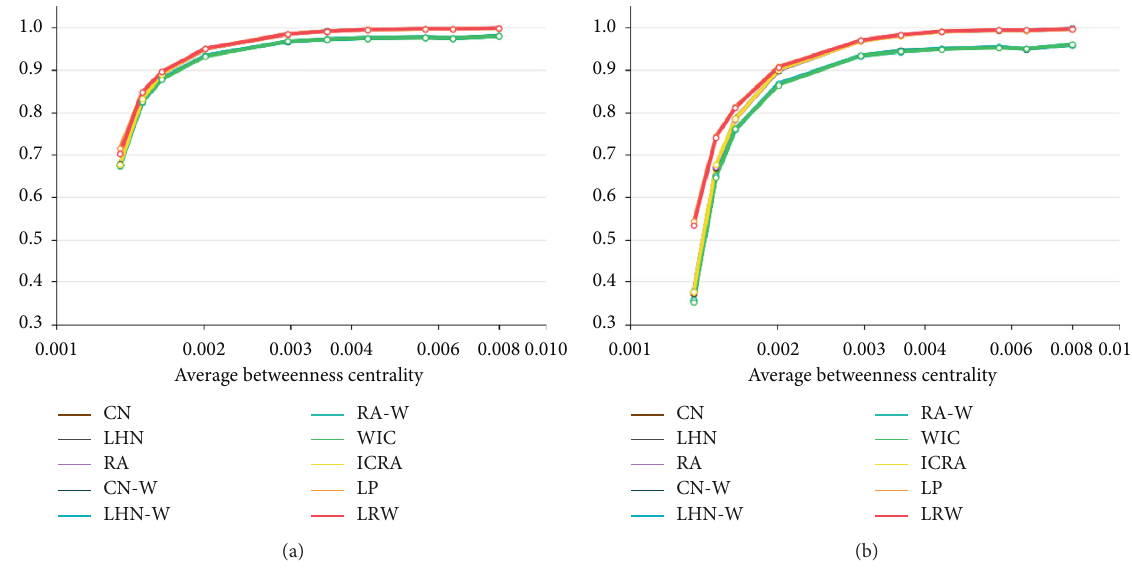
Figure 9: Performance of each predictor under AUC and W-index in WS-Group4. (a) Accuracy measured by AUC. (b) Accuracy measured by